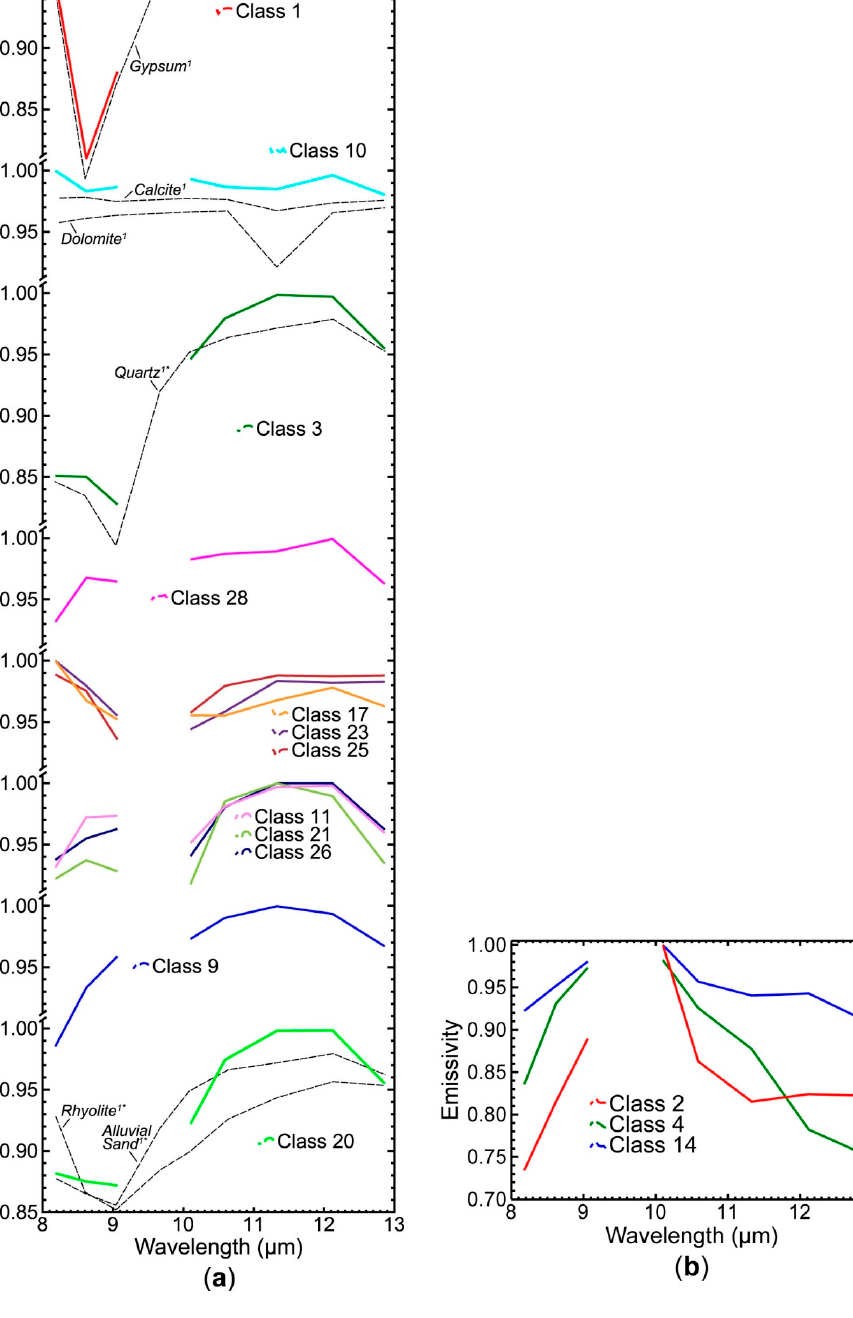
Figure 9. Selected longwave infrared (LWIR) image endmember spectra modeled predominantly in areas of: ( a ) natural terrain; ( b ) manmade surfaces, and example reference spectra convolved to the MODIS/ASTER Airborne Simulator (MASTER) bandpasses. 1 ASTER Spectral Library [62]. * spectrum’s vertical scale has been decreased to facilitate comparison and plotting.